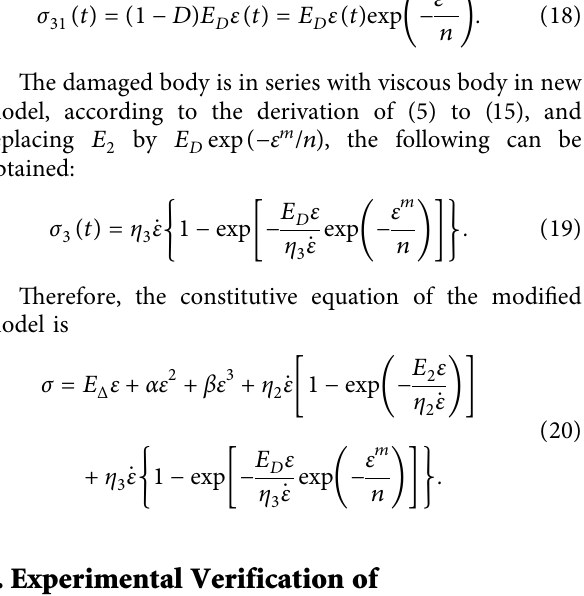
Figure 4: The modified